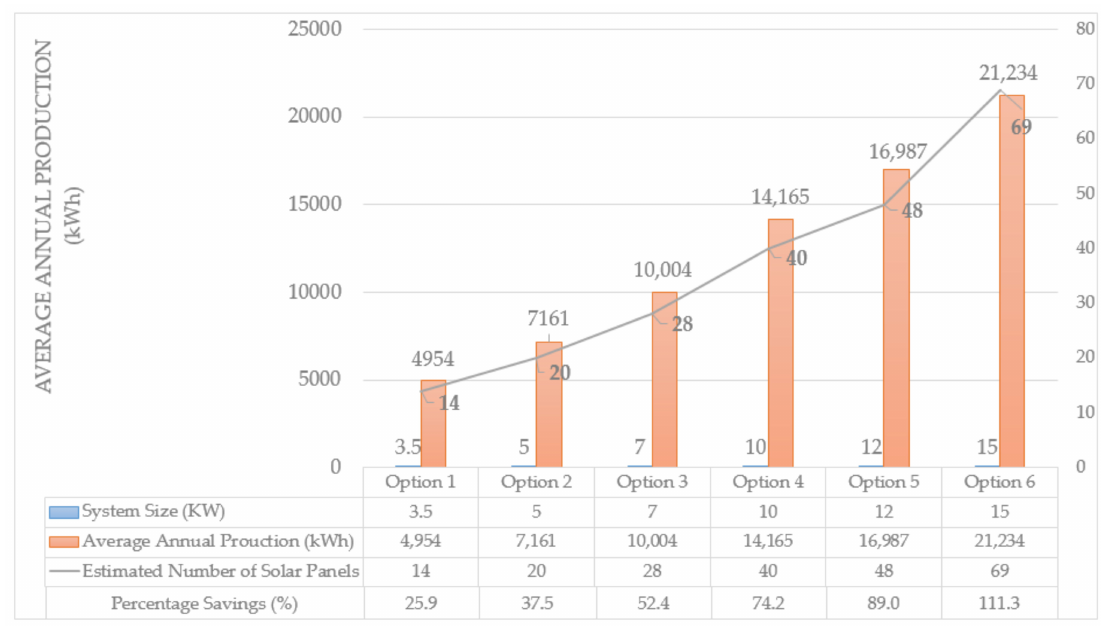
Figure A1. Evaluated Photovoltaics (PV)